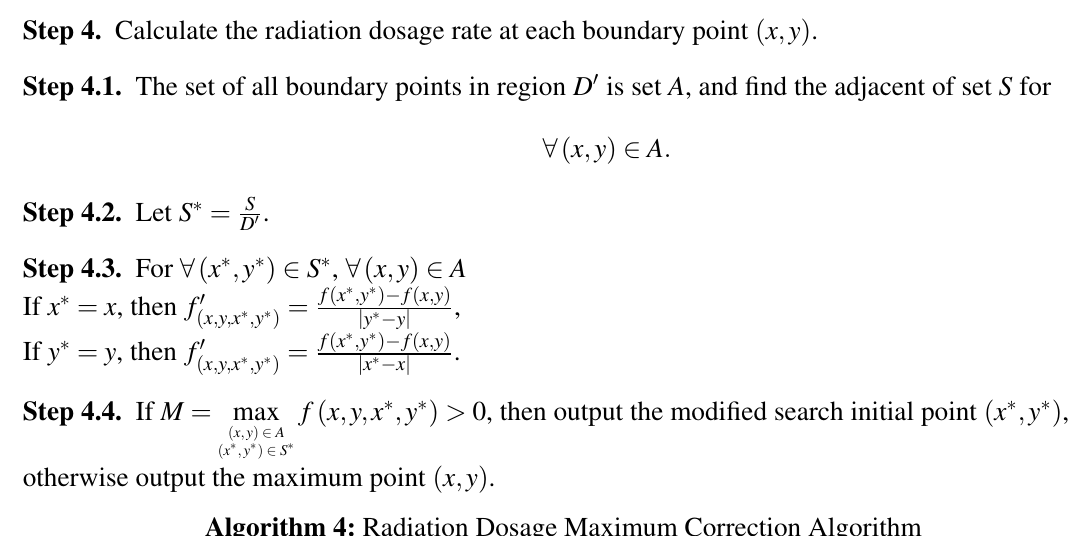
Algorithm 4: Radiation Dosage Maximum Correction